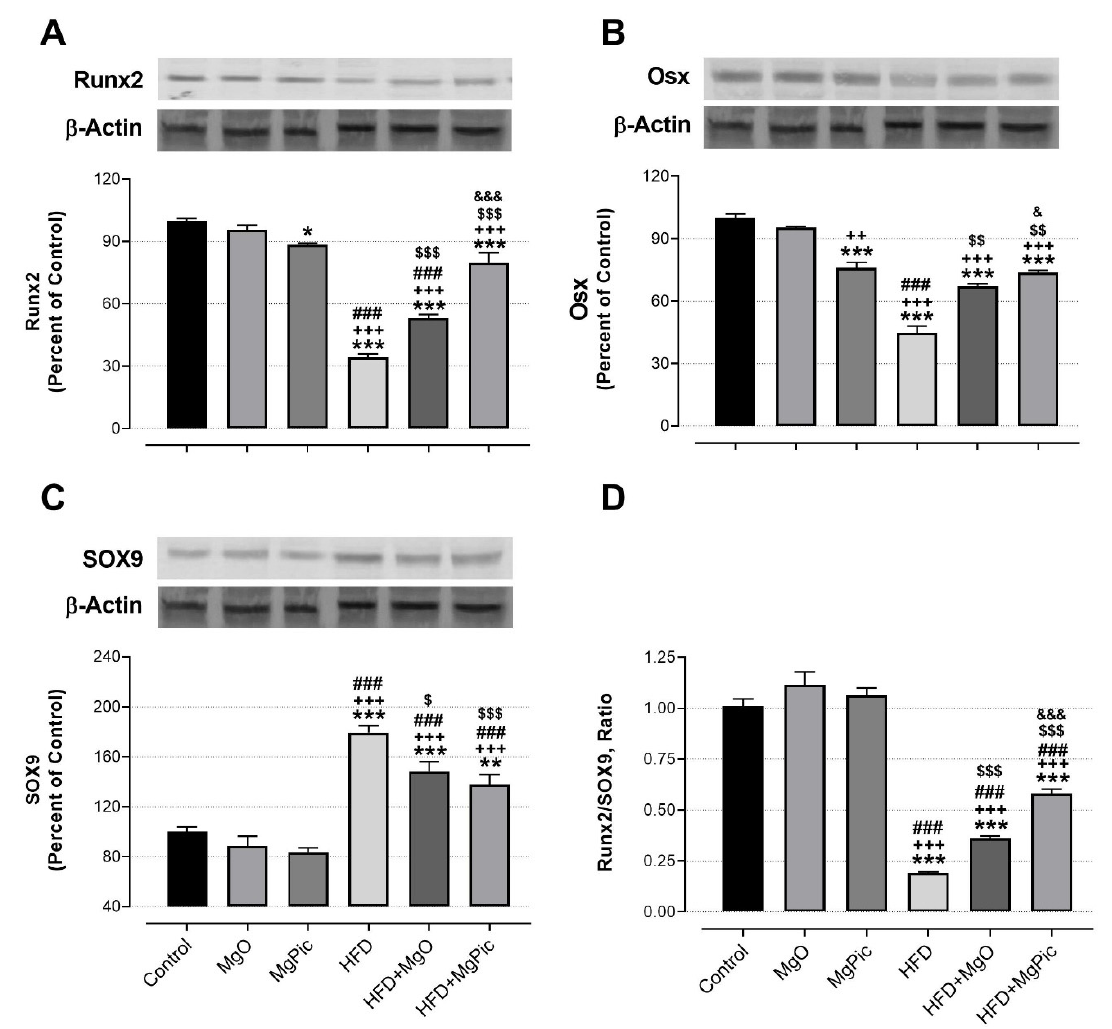
Figure 3. Effects of MgO or MgPic supplementation on bone ( A ) Runx2; ( B ) Osx; ( C ), SOX9; ( D ) Runx2/SOX9 levels in rats. Blots were repeated at least three times, and β -actin was used for loading control. The blots were cropped, and full-length blots are presented in Supplementary Figure S3. Data (percent of the control group) are shown as mean ± standard error of the mean. Different symbols indicate the statistical difference between groups (* p < 0.05, ** p < 0.01, and *** p < 0.001 as compared with the control group; ++ p < 0.01 and +++ p < 0.001 as compared with the MgO group; ### p < 0.001 as compared with the MgPic group; $ p < 0.05, $$ p < 0.01, and $$$ p < 0.001 as compared with the HFD group; & p < 0.05 and &&& p < 0.001 as compared with the HFD + MgO group). One-way ANOVA and Tamhane’s T2 (Osx) or Tukey’s (Runx2 and SOX9) post hoc test were used and for statistical analysis. Kruskal–Wallis and Mann–Whitney U tests with Bonferroni correction were used for the Runx2/SOX9 ratio ( p < 0.01).